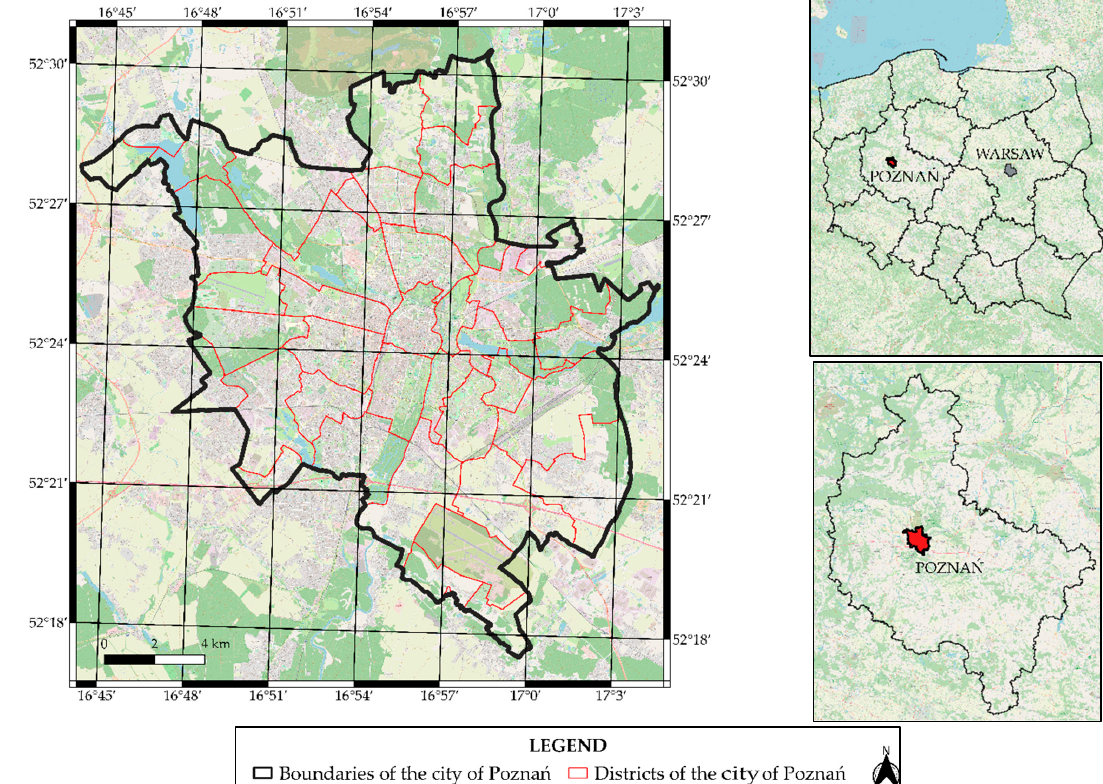
Figure 1. Location of the research facility—Pozna ń .